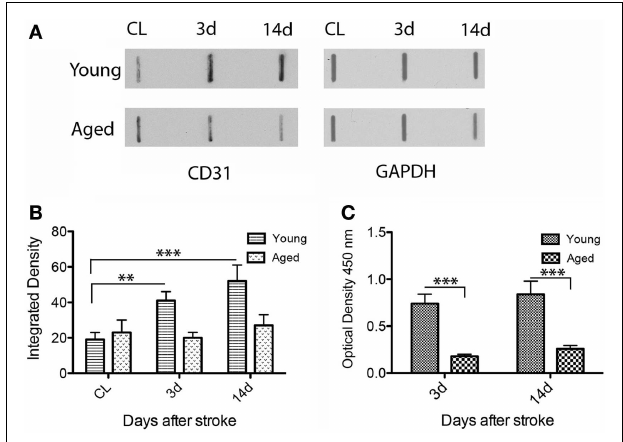
FIGURE 4 | Quantitative analysis of CD31 expression in the rat model . By dot blot (A) and ELISA analysis (C) , CD31 immunoreactivity in the peri-infarcted area was slightly increased from day 3 to day 14 in both age groups. However, CD31 levels in the young animals were clearly higher than those in aged animals both at day 3 (fourfold; p = 0.001) and day 14 (threefold; p = 0.001) both by dot blot (B) and ELISA (C)